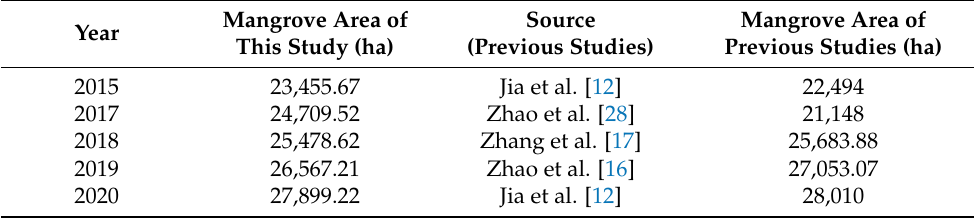
Table 3. Comparison of mangrove areas in existing Chinese